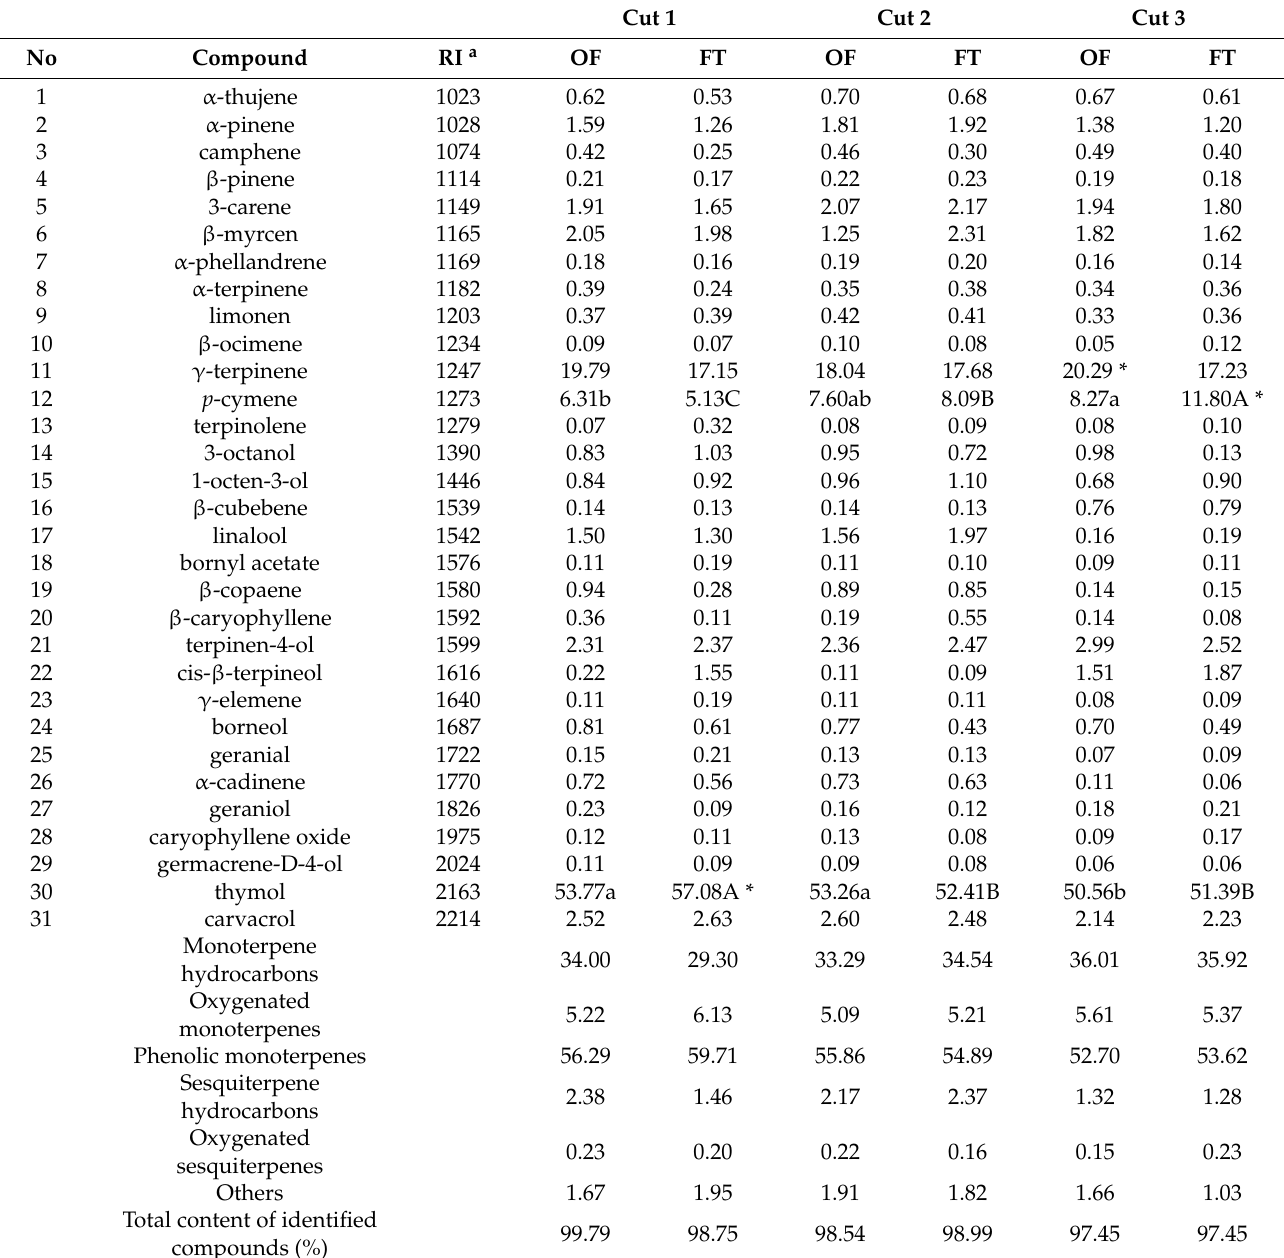
Table 3. Chemical composition of essential oils from common thyme herb (% peak